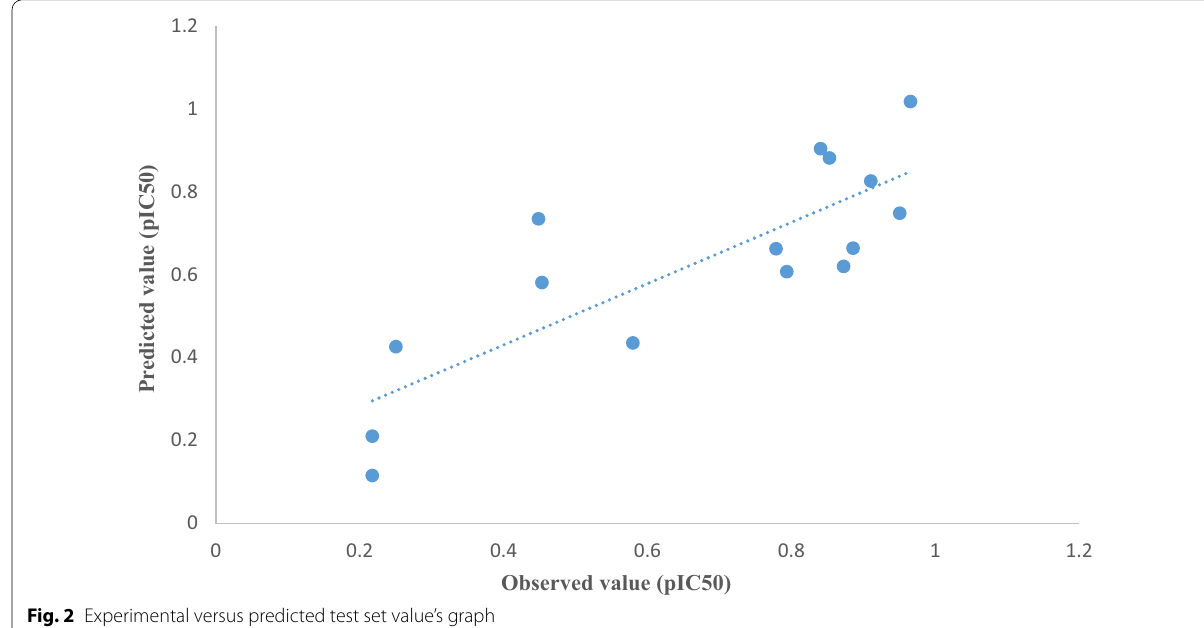
Fig. 2 Experimental versus predicted test set value’s graph